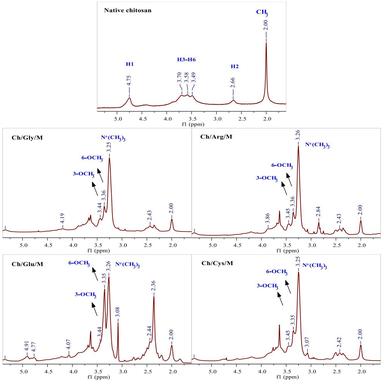
1 H HR-MAS-NMR spectra of native and methylated amino acid-grafted chitosan.